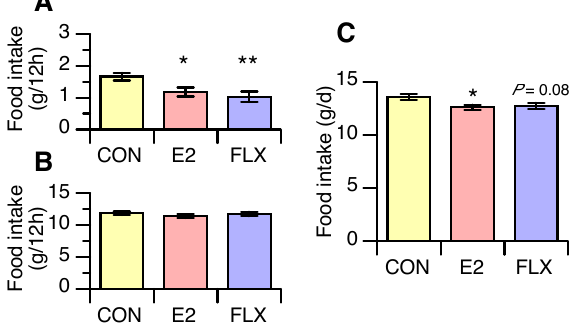
Figure 3. The e ff ect of estradiol (E2) replacement or fluoxetine (FLX) administration on food intake during the light phase ( A ) and dark phase ( B ), and daily food intake ( C ) in ovariectomized female rats. Female rats were ovariectomized and assigned to the estradiol- or cholesterol-treated group. Six or seven days after ovariectomy, half of the cholesterol-treated rats were subcutaneously ( s.c. injected twice daily with 5 mg / kg fluoxetine (FLX) at ZT0 and ZT12, while the other half of the cholesterol-treated rats (CON) and all of the estradiol-treated rats (E2) were s.c. injected with the same volume of saline. Data are shown as the mean ± SEM ( n = 13 in CON, n = 14 in E2, n = 13 in FLX). Note: * and **: significant di ff erences at p < 0.05 and p < 0.01, respectively, compared to the CON group.